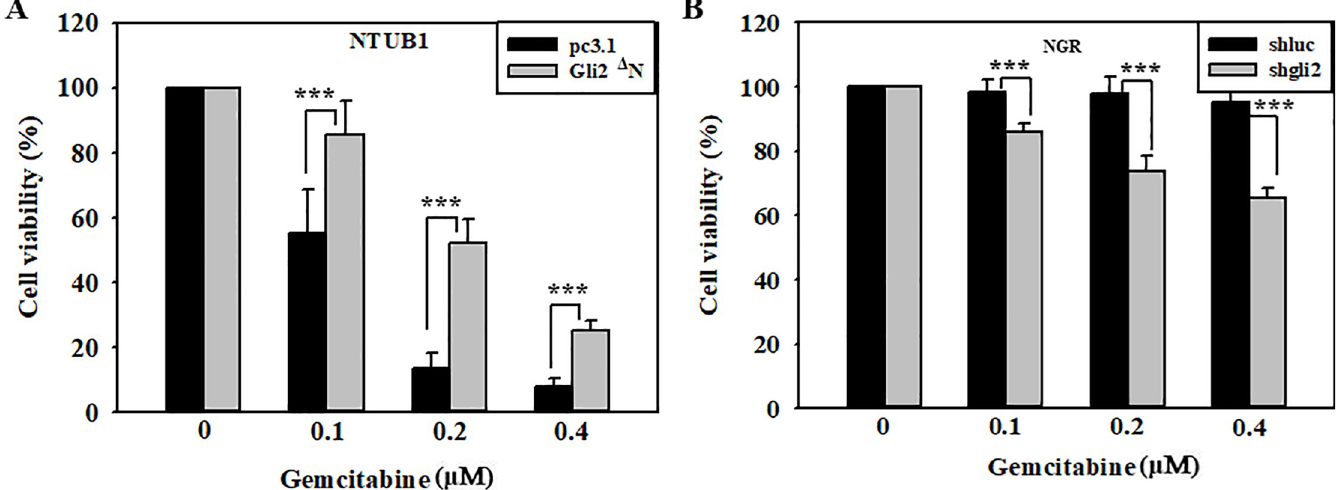
Fig 4. Contribution of Gli2 expression to gemcitabine resistant UC cells. (A) NTUB1 or (B) NGR cells were transfected with (A) pCS2MT-Gli2 Δ N plasmids or (B) Gli2 specific shRNA plasmids, respectively, and then treated with various doses of gemcitabine (0 − 0.4 μ M) for 72 h. Cells were trypsinized and counted numbers by using a counting chamber to measure cellular